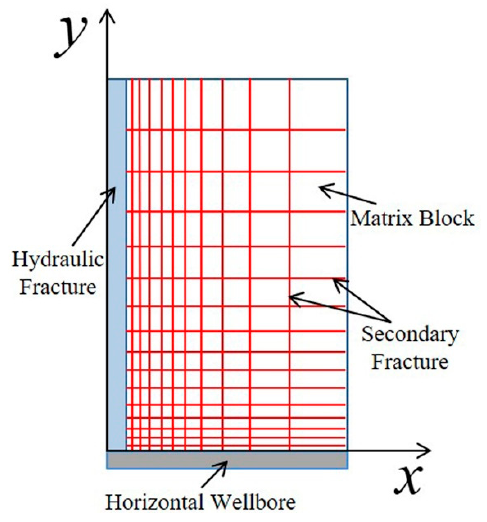
Figure 1. Plane figure of heterogeneous structure model for fracture network.